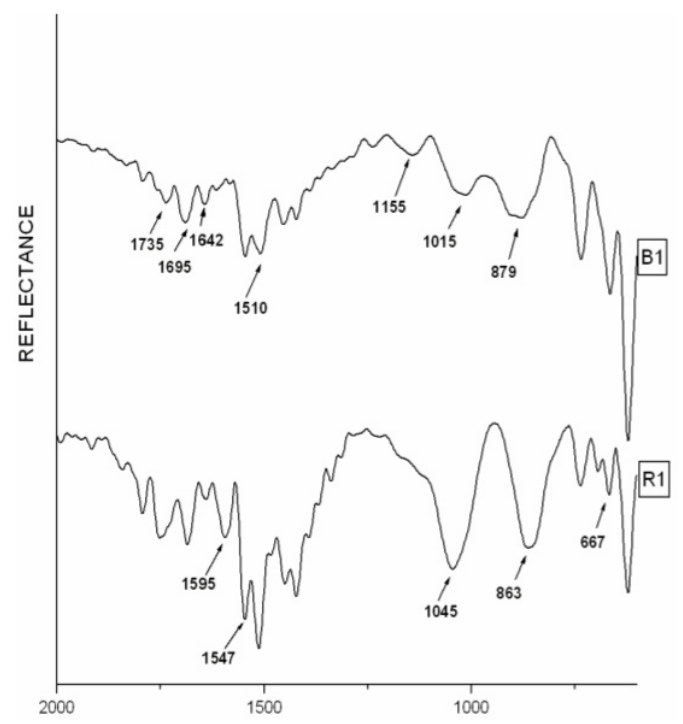
Figure 1. FTIR-VAR spectra of Romanite and Baltic geological amber samples, range 2000-600 cm -1